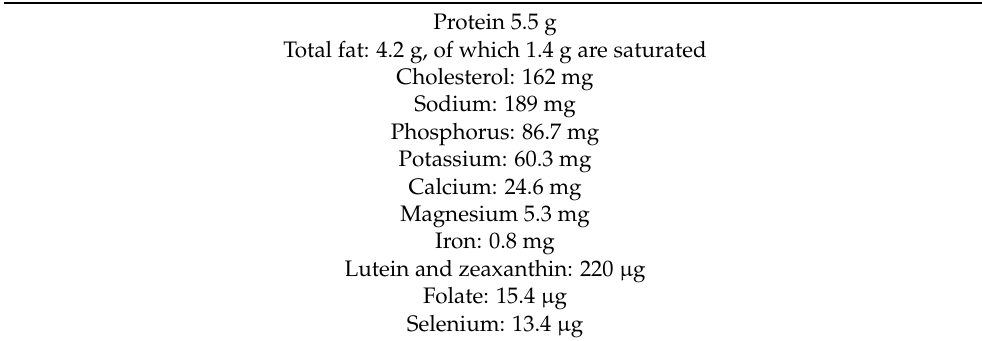
Table 1. Main nutrient contents in one boiled or poached egg weighing 44 g according to the United States Department of Agriculture [27].